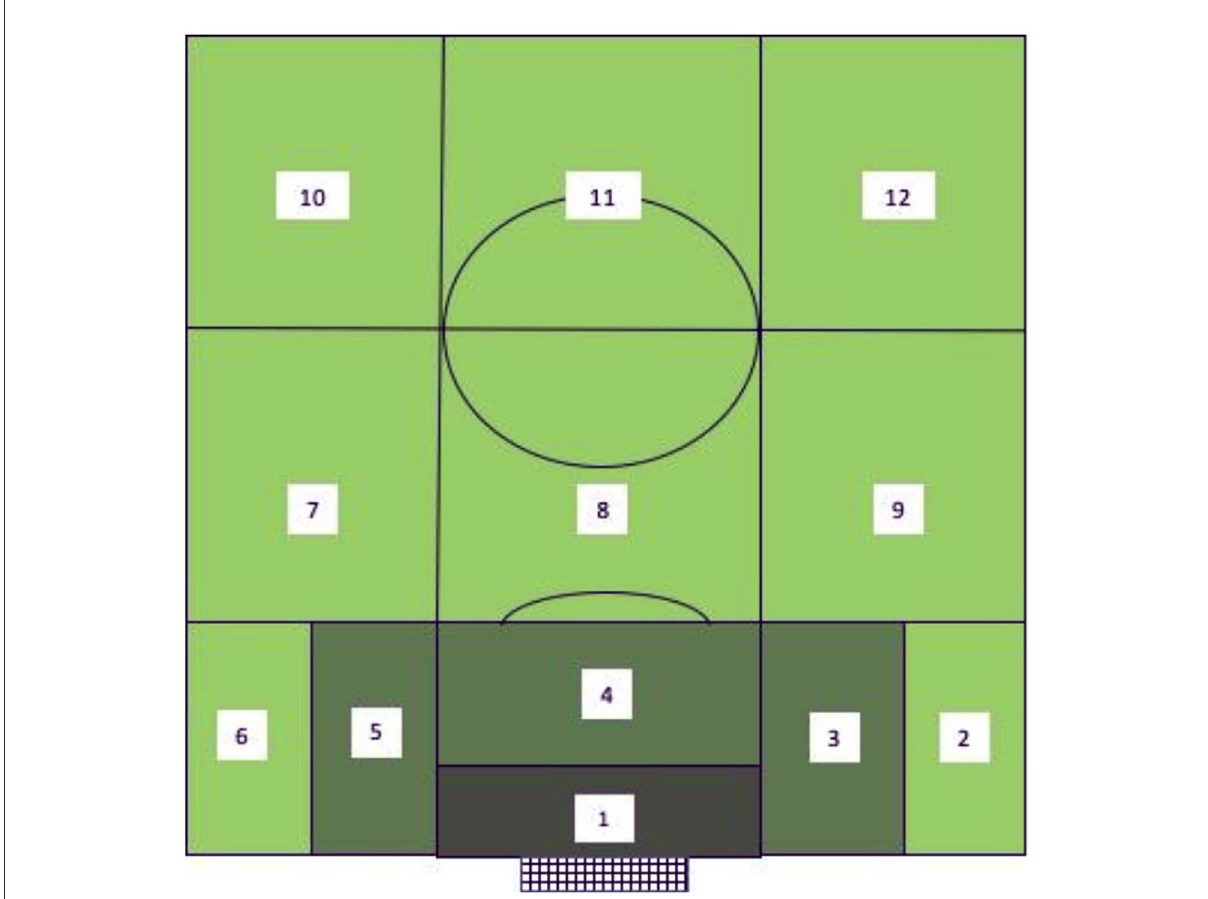
FIGURE2 Campogram for offensive technical-tactical actions (adapted from Lapresa Ajamil et al.,